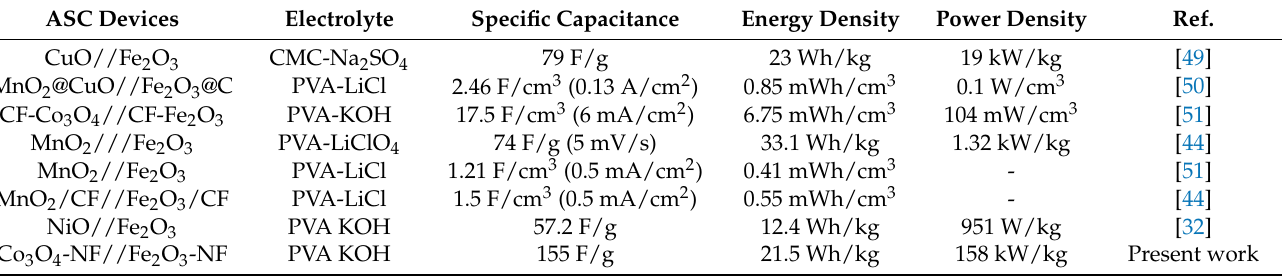
Table A2. The electrochemical performance of the ferric-oxide-based ASC